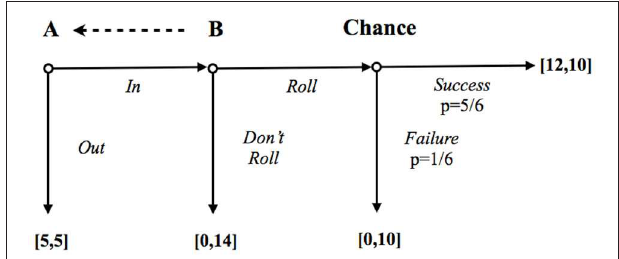
FIGURE 1 | The risky Trust game of Charness and Dufwenberg (2006). The dashed arrow means that the trustee (B) can unilaterally send a message to the trustor (A). Payoffs are expressed in